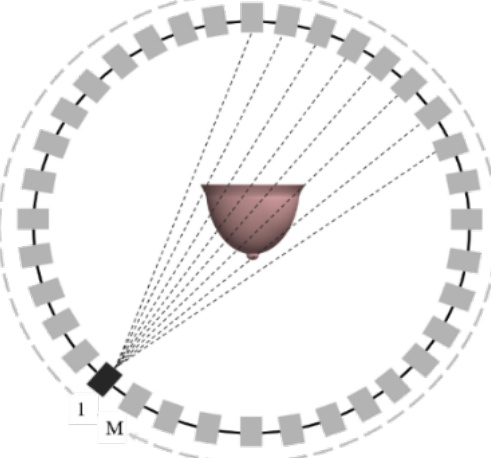
Figure 5. Attenuation coefficient ultrasound tomography setup. The attenuation coefficient of breast tissue was reconstructed by a filtered back- projection reconstruction method based on equiangular fan beam scanning. The parameter relationship of this method is shown in Figure 6, where the polar coordinates of point M in the reconstructed image are ( r , φ ) , S 0 E is the ray passing through point M in fan beam, the flare angle is γ , and the length of line segment S 0 M is L . The relationships between the parameters satisfied Equation (9). p ( t , θ ) and p f ( γ , β ) respectively represent the projections in a rotating coordinate system and in a polar coordinate system. t represents the distance from the origin of the rotating coordinate system to the ray.